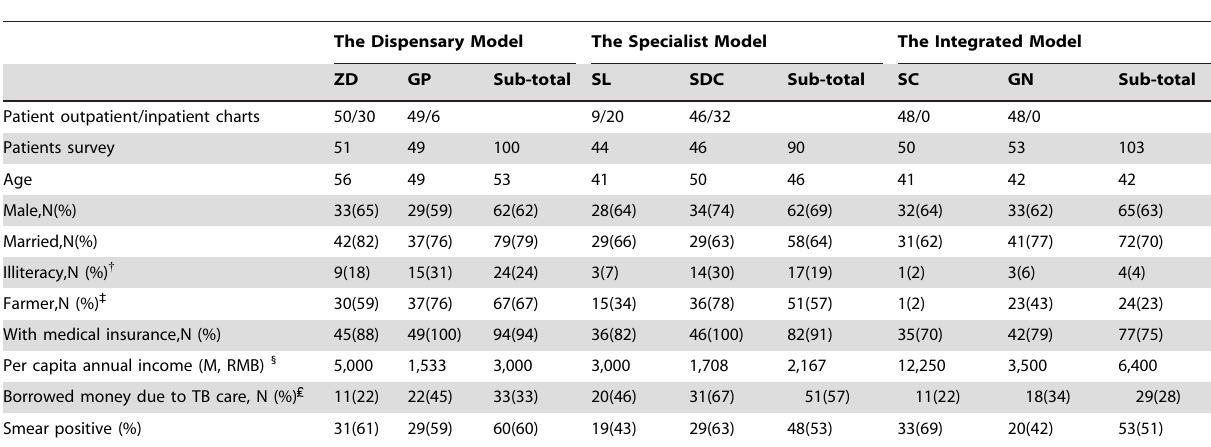
Table 2. Participants in each site and the general information of the patient